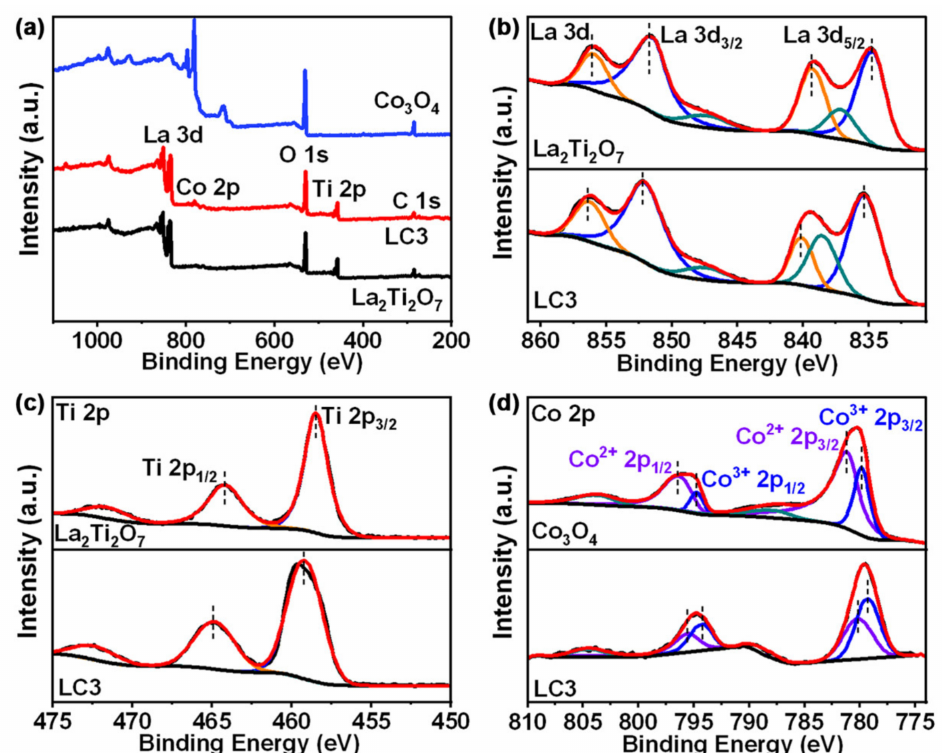
Figure 4. ( a ) XPS survey spectra of La 2 Ti 2 O 7 , Co 3 O 4 and LC3. High-resolution XPS spectra of ( b ) La 3d, ( c ) Ti 2p, and ( d ) Co